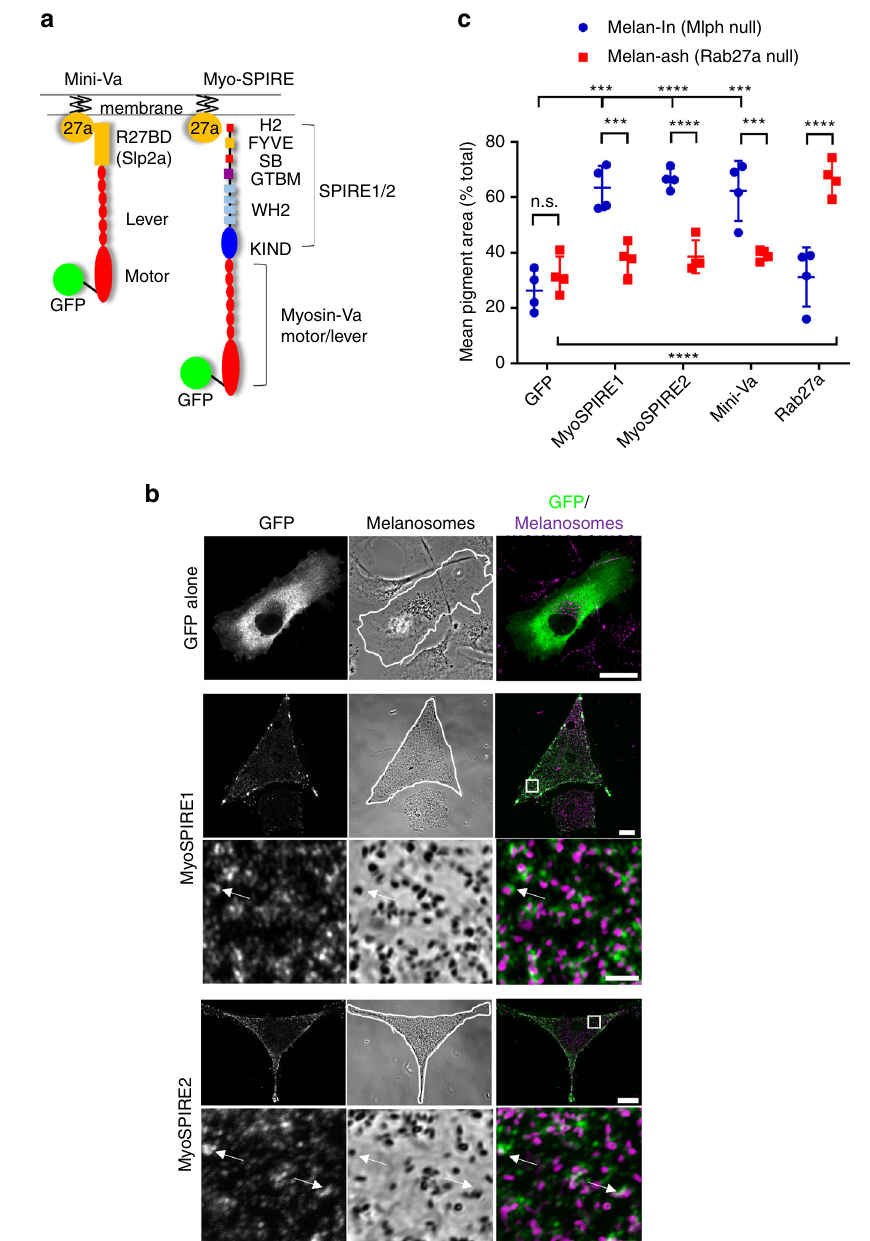
Fig. 8 Functional evidence that SPIRE1/2 interact with melanosome-associated Rab27a in melanocytes. melan-ln (Mlph null) and melan-ash (Rab27a null) melanocytes were infected with viruses expressing the indicated proteins. Cells were fi xed after 24 h, stained with GFP-speci fi c antibodies, and the intracellular distribution of GFP-fusion proteins and melanosomes was observed using a confocal microscope (see Experimental procedures). a A schematic representation of the structure of mini-Va and myoSPIRE1/2 proteins, and their interaction with membrane-associated endogenous Rab27a. R27BD Rab27-binding domain, SB SPIRE box, GTBM globular tail binding domain. b Single confocal z -sections showing the distribution of expressed proteins, melanosomes and their colocalisation (from left to right). In merge images melanosomes are false-coloured magenta. For myoSPIRE1/2 upper and lower panels are low and high-magni fi cation images. Boxes in low-magni fi cation images indicate the area presented in the high-magni fi cation images below. Scale bars = 10 μ m in main images and 2 μ m in magni fi ed portions. Arrows indicate colocalisation of spots of myoSPIRE with melanosomes. Cell outlines are shown by white lines in phase contrast (melanosome) images. c A bee swarm plot showing the effect of expression of myoSPIRE and other proteins on melanosome distribution in melanocytes (melan-ln/Mlph null and melan-ash/Rab27a null). Data presented are mean pigment area measurements from four independent experiments. In each case, pigment area was measured for ten cells expressing each of the different proteins. ****, *** and n.s. indicate signi fi cant difference p = <0.0001, 0.001 and none between the datasets linked by horizontal bars as determined by one-way ANOVA. Bars within datasets indicate the mean and 25th and 75th percentile of data. Source data for c are provided in the supplementary Source data fi